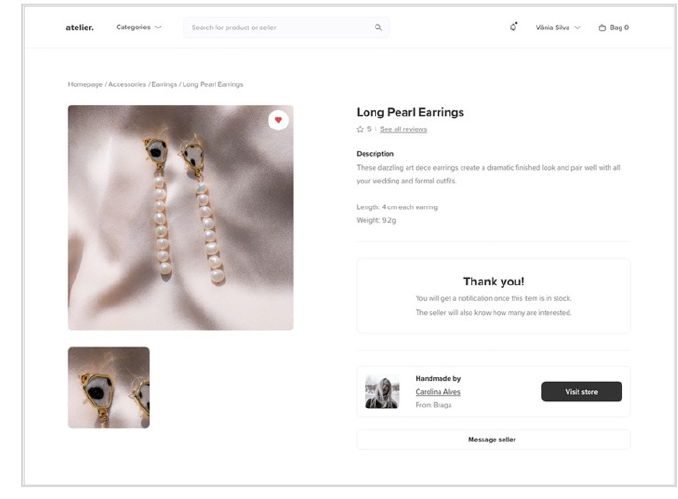
Figure 12. Design change: Visit store button. Self-source, 2020.